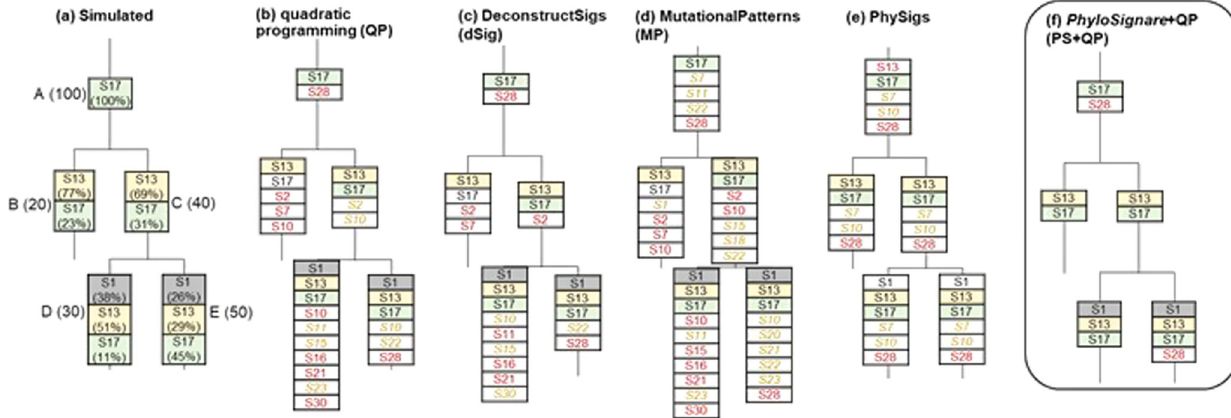
Fig. 2 Mutational signatures detected by different methods for individual branches in the simulated clone phylogeny. a Model clone phylogeny and simulated mutational signatures. There are fi ve branches: A – E with 20 – 100 variants (counts in parentheses next to the branch name) and each signature ’ s relative activity (shown below the signature name). See Methods for the detail. b – e Mutational signatures inferred by using different methods: b Quadratic programming [QP], c DeconstructSigs [dSig], and ( d ) MutationalPatterns [MP]. These methods QP, dSigs, and MP are expected to show limited accuracy due to a small number of variants. e Mutational signatures are inferred using PhySigs (optimal solution), which consider the evolution of mutational signatures along clone phylogenies. f Mutational signatures are inferred by applying the PhyloSignare approach with the QP Method (PS + QP). The number of incorrect signatures detected became smaller after coupling QP with PhyloSignare . Incorrectly detected signatures are shown with red (>5% estimated relative activity) and yellow italic (0.1% – 5% estimated relative activity) letters, and correct signatures not detected are shown in white boxes with black